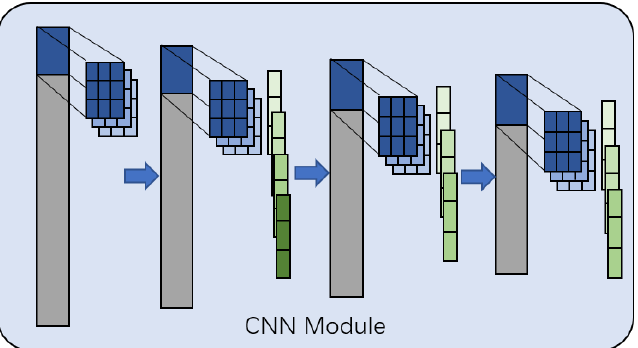
Figure 2. The framework of the CNN